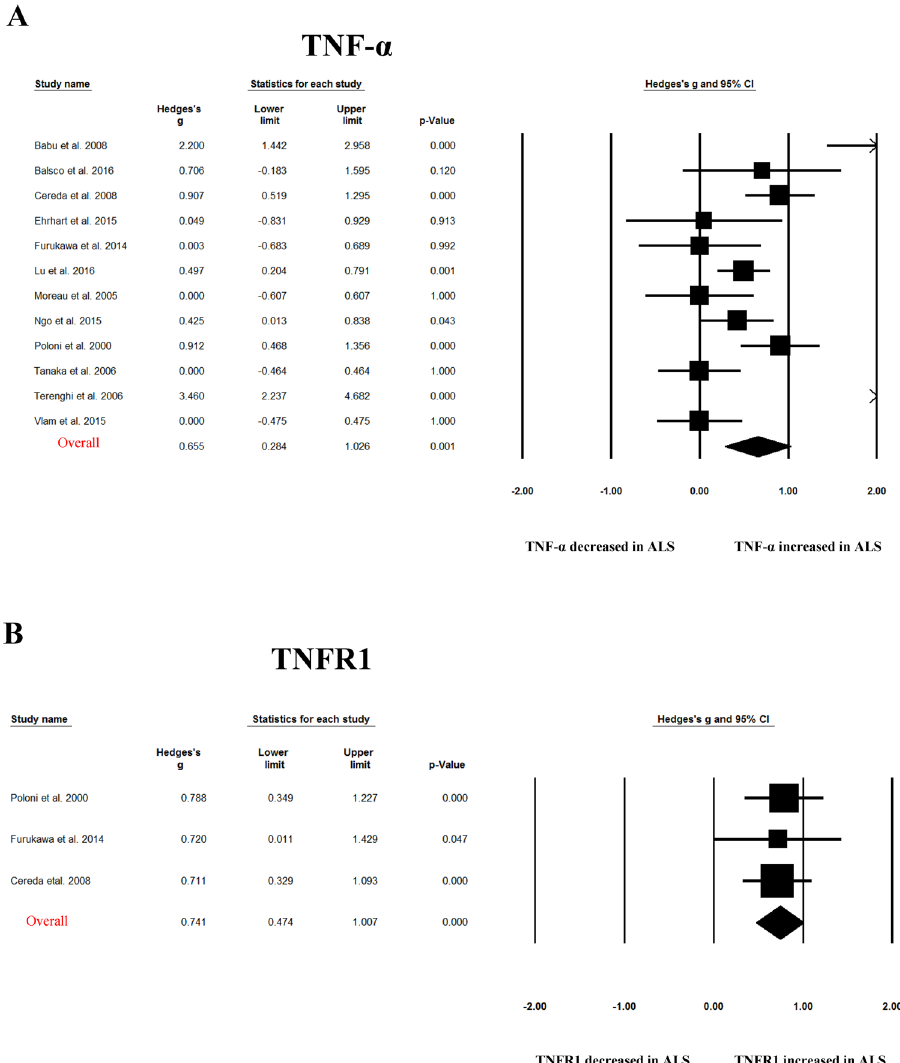
Figure 2. Studies of peripheral blood TNF- α and TNFR1. Forest plot displaying random effects meta-analysis results of the association between TNF- α (A) , TNFR1 (B) and ALS. The sizes of the squares are proportional to study